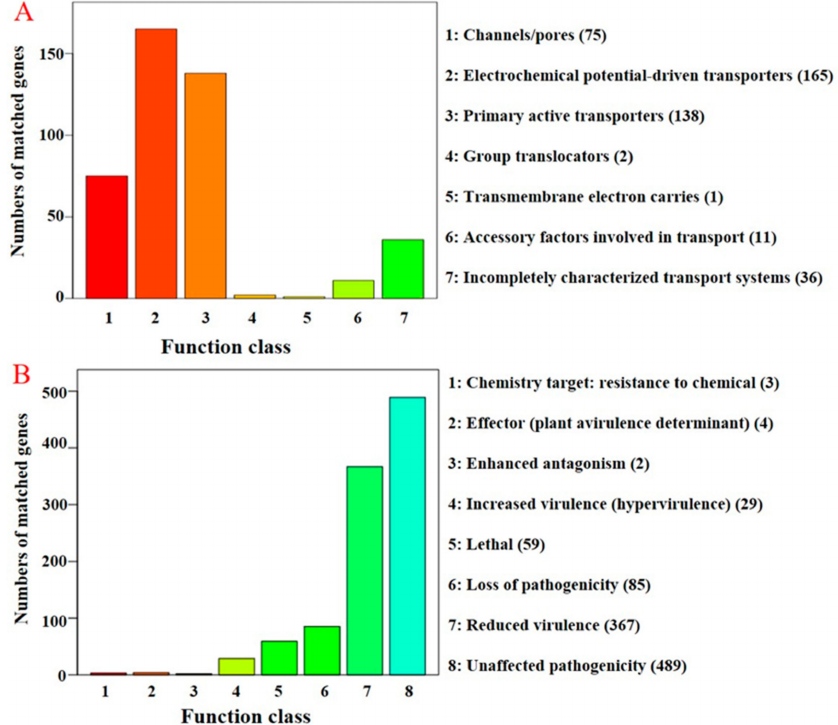
Figure 3. Distribution of the number of membrane transport proteins and pathogen–host